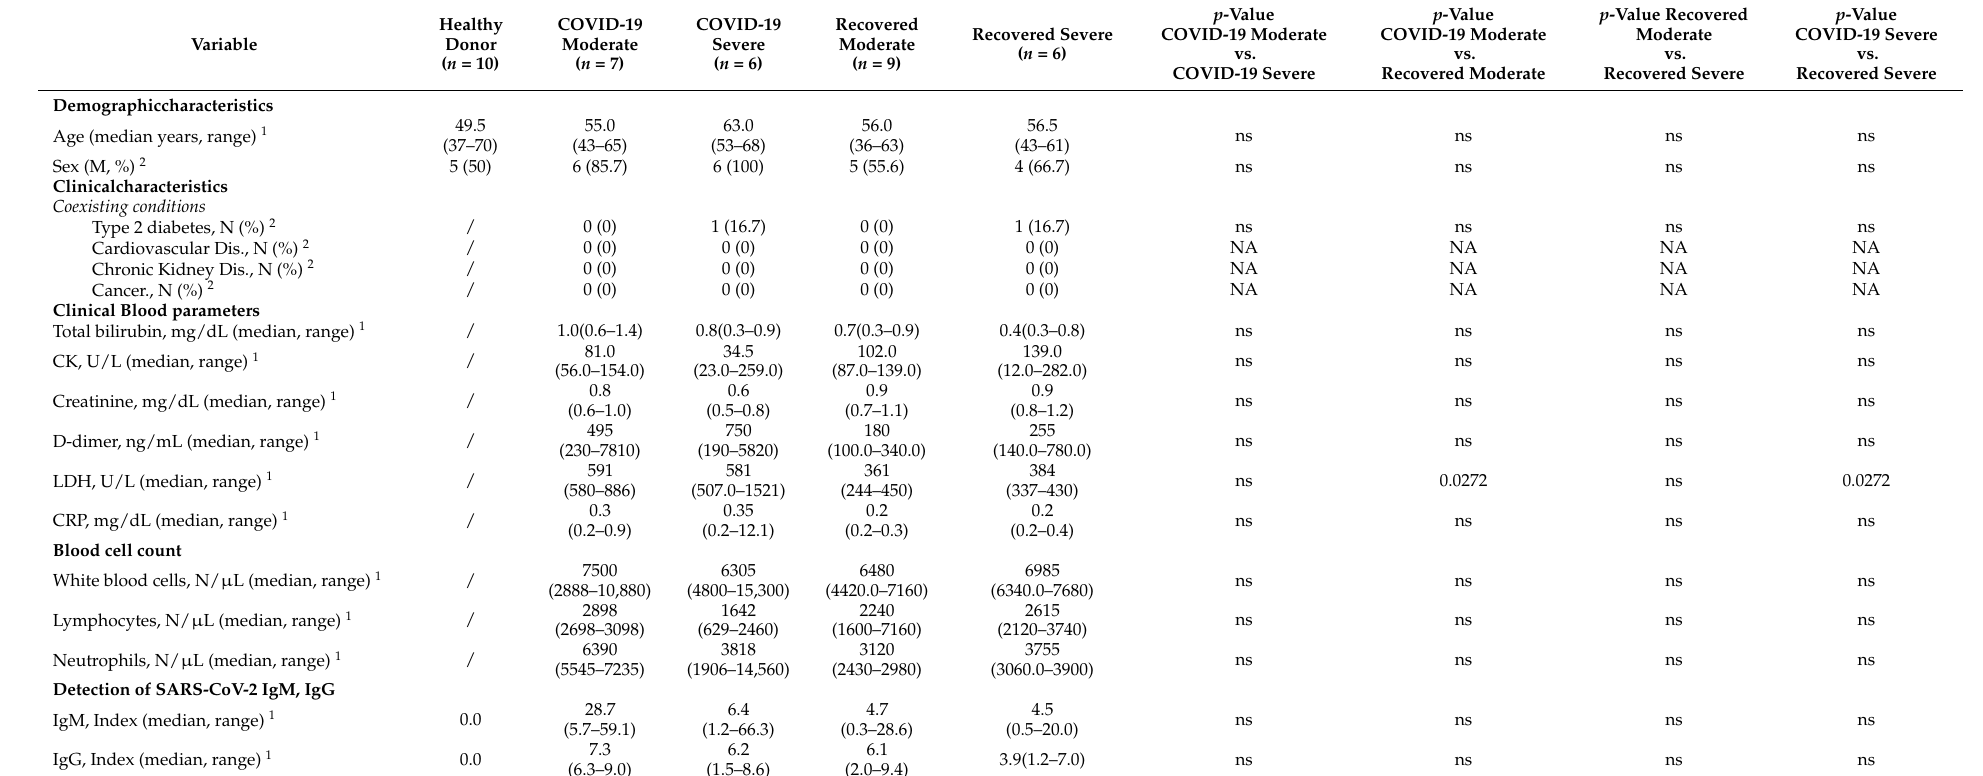
Table 1. Demographic and clinical characteristics of healthy donors (HD), COVID-19 and recovered